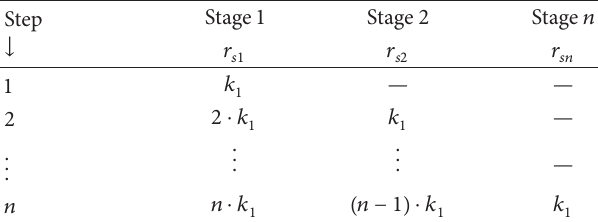
Table 1: Linear progression model [5]. Table 2: Fouling severity assignment table [4].